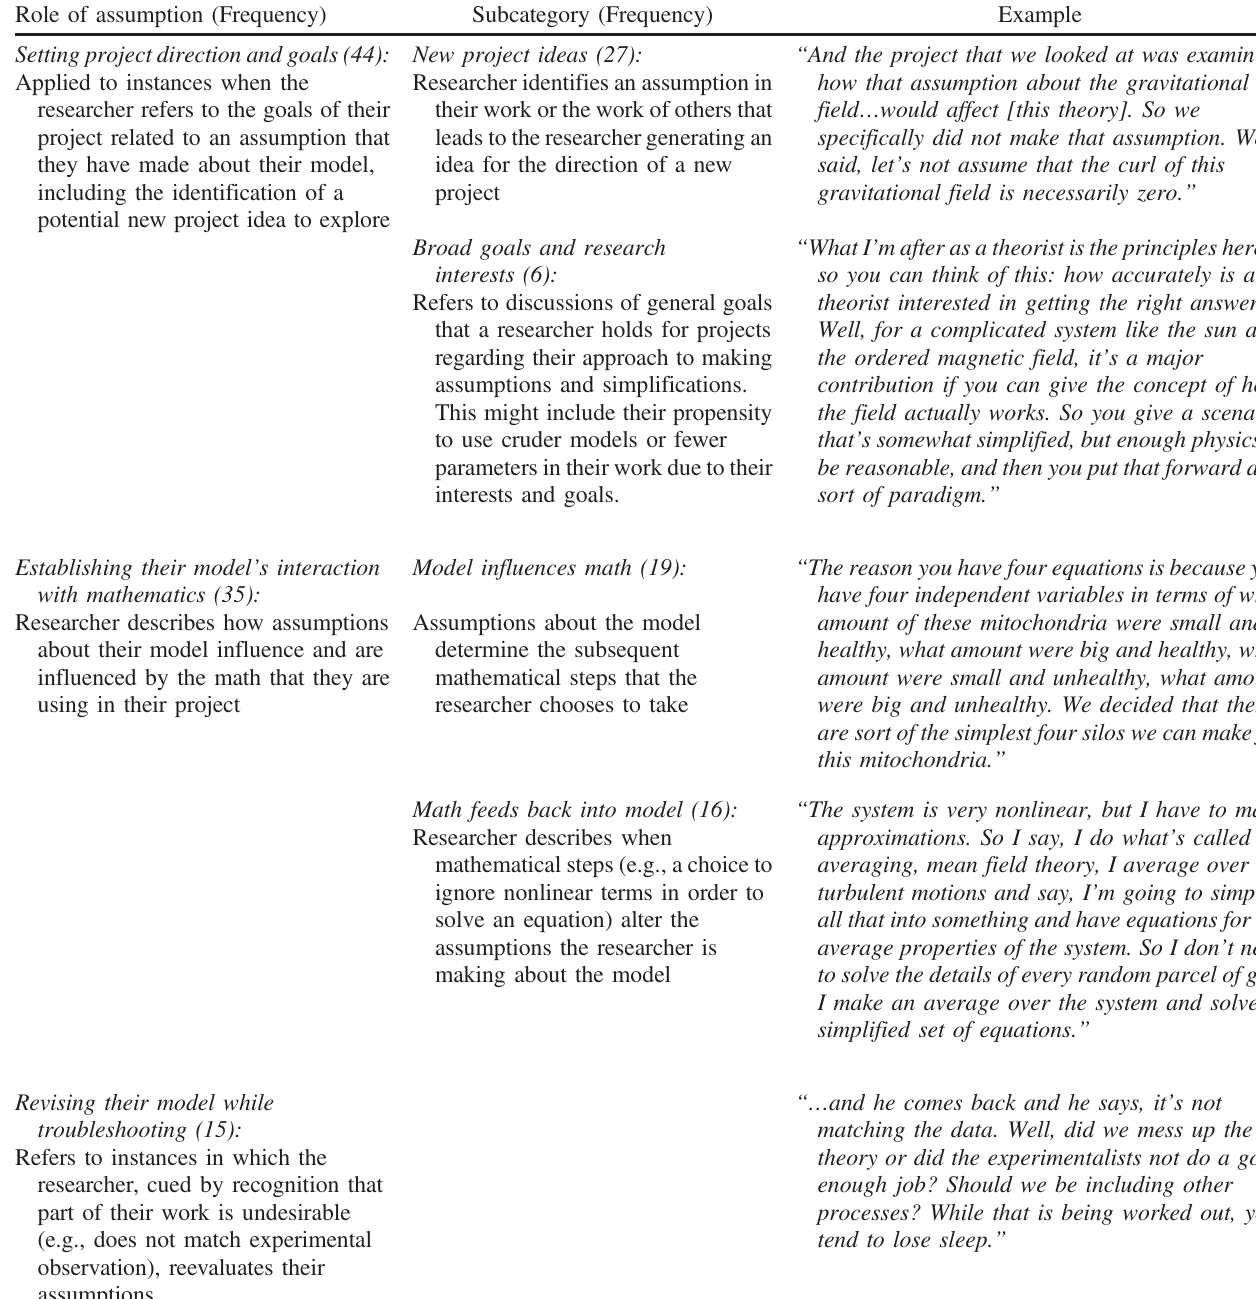
TABLE VI. Code descriptions and representative examples for assumptions. Role of assumption